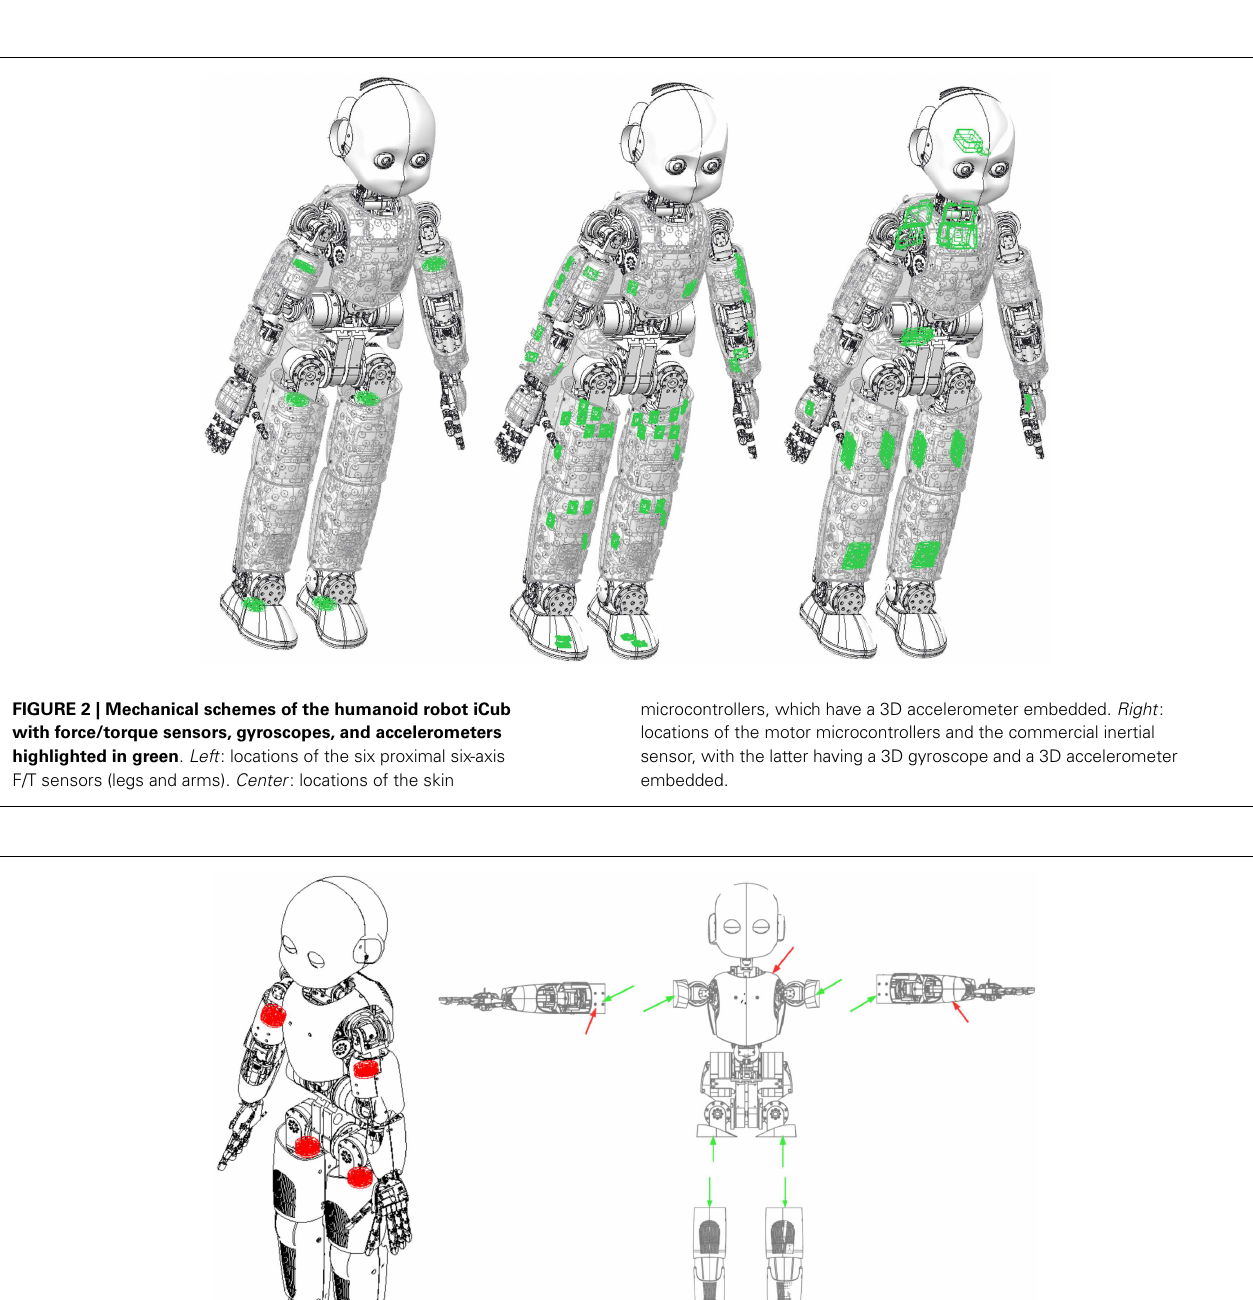
independent floating-base structure subject to an external wrench, which coincides with the one measured by the F/T sensor (green arrow). Red arrows represent possible location for the unknown external